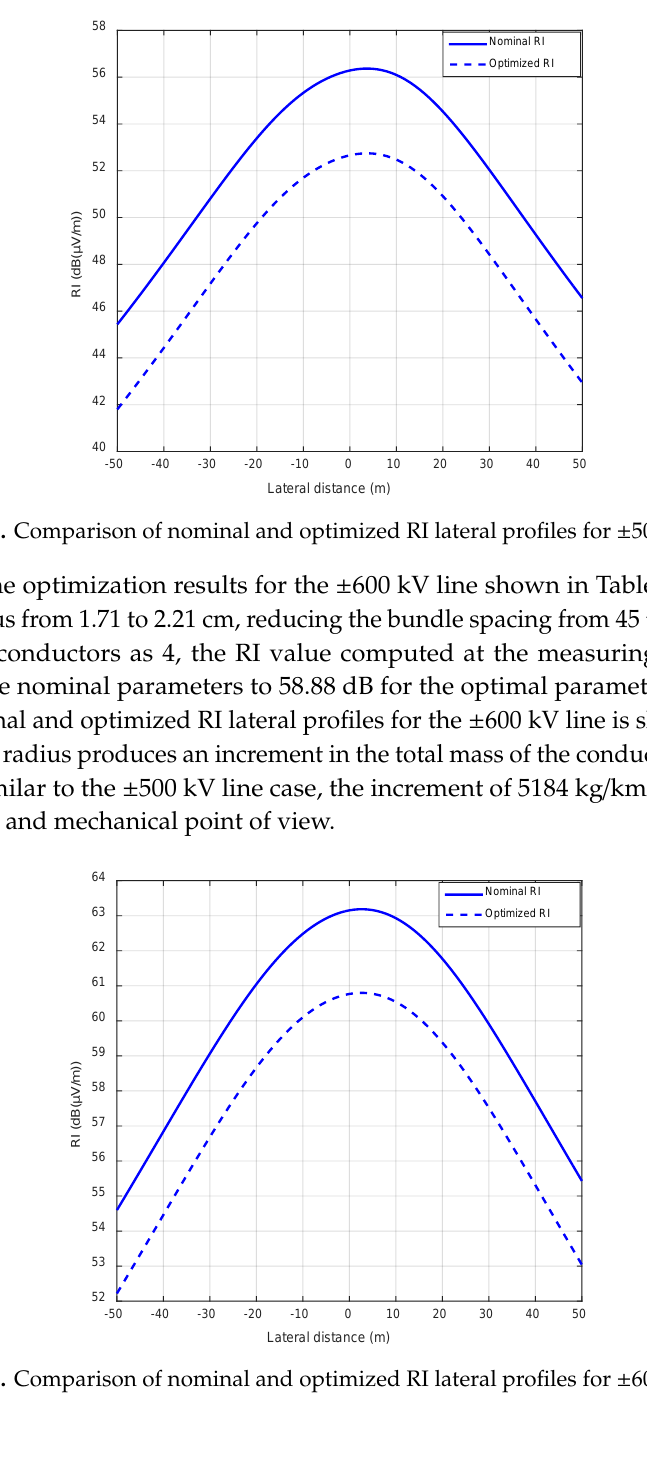
Figure 11. Comparison of nominal and optimized RI lateral profiles for ±600 kV line.